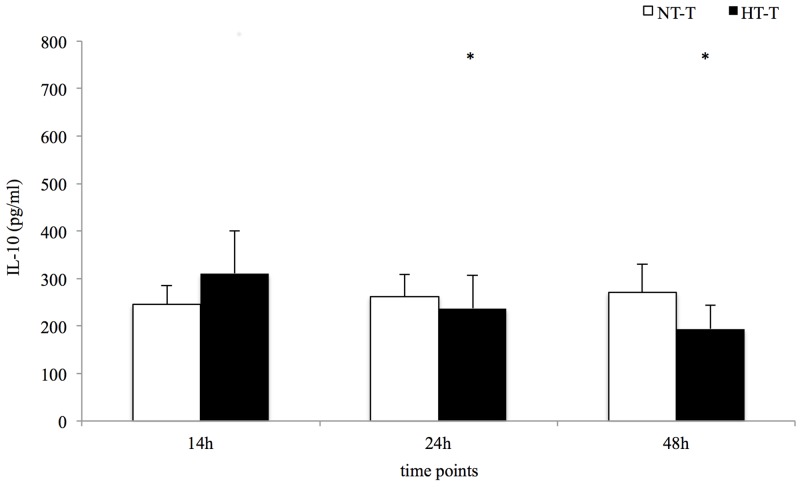
Local IL-10 concentrations.Statistical significance p = <0.05 (* from baseline).